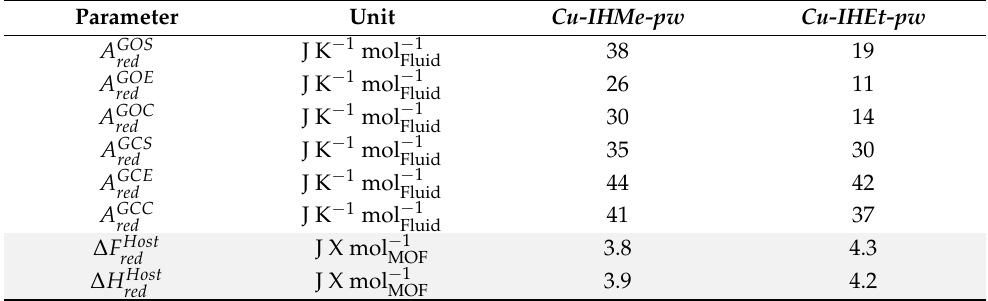
Table 1. Reduced sorption potential for gate-opening boundaries and calculated ∆ F Host values (underlined grey) of Cu-IHMe-pw and Cu-IHEt-pw taken from the characteristic dual DA